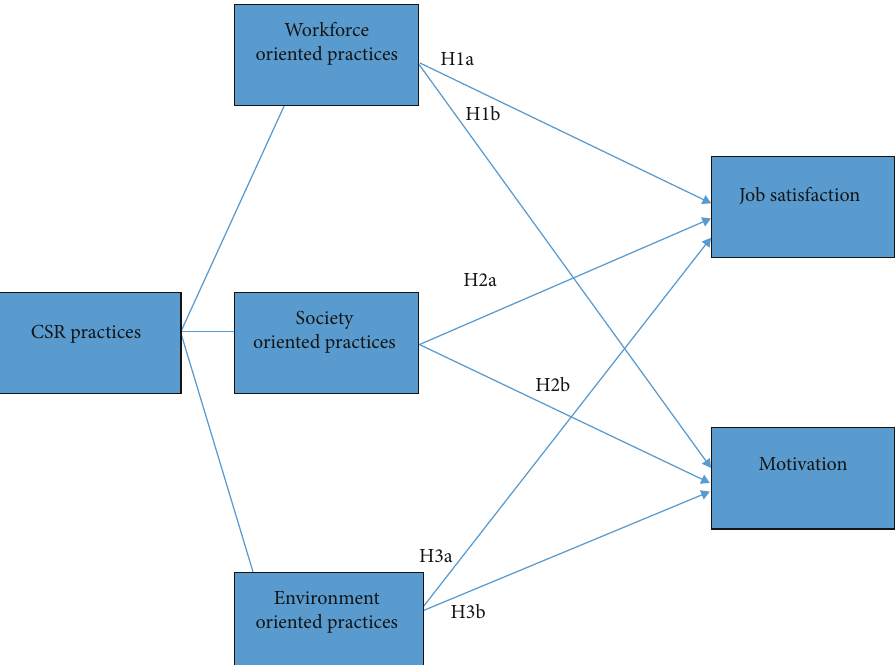
Figure 1: Proposed research model designed by authors. H1a: there is a positive relationship between workforce-oriented CSR practices and rural worker job satisfaction. H1b: there is a positive relationship between workforce-oriented CSR practices and rural workers ’ motivation. H2a: there is a positive relationship between society-oriented CSR practices and rural workers ’ job satisfaction. H2b: there is a positive relationship between society-oriented CSR practices and rural workers ’ motivation. H3a: there is a positive relationship between environmental-oriented CSR practices and rural workers ’ job satisfaction. H3b: there is a positive relationship between environmental- oriented CSR practices and rural workers ’